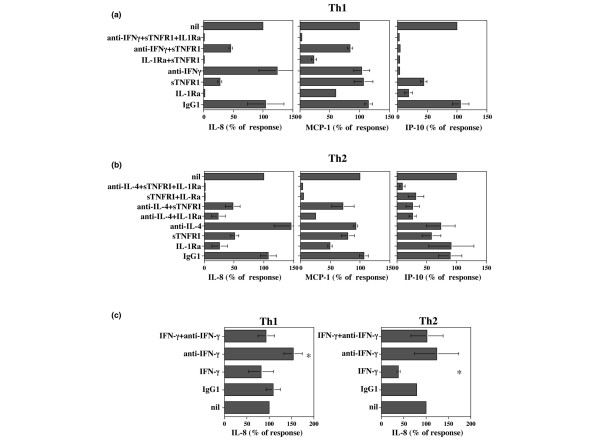
Differential effect of T cell membrane-associated cytokines in inducing IL-8, MCP-1, and IP-10. Fibroblasts were plated at 2 × 104 cells/well; 72 hours later the culture medium was replaced and T cell membranes corresponding to 2 × 105 cells generated from activated Th1 (panel a, n = 2; panel c, n = 4) and Th2 (panels b and c, n = 2) clones were added to the wells in triplicate cultures. Anti-TNF (soluble TNF receptor I; 10-8 mol/l), IL-1 receptor antagonist (2 μg/ml), anti-IFN-γ (10 μg/ml), anti-IL-4 (10 μg/ml), irrelevant monoclonal IgG1 (10 μg/ml) and IFN-γ (1,000 U/ml), alone or in combination, were added to the wells 30 minutes before T cell membranes. Chemokine levels were determined in the supernatants by enzyme-linked immunosorbent assay upon 48 hours of further culture. The bars represent the mean percentage ± standard error of chemokine production in the presence of T cell membranes without blocking agent. (a) IL-8 was 8.8 ± 1.9 ng/ml, MCP-1 was 4.7 ± 0.2 ng/ml and IP-10 was 7.3 ± 1.1 ng/ml. (b) IL-8 was 36.5 ± 8.8 ng/ml, MCP-1 was 6.6 ± 0.9 ng/ml and IP-10 was 0.8 ± 0.3 ng/ml. Note that basal IL-8 levels were fourfold lower and IP-10 tenfold higher in the presence of Th1 compared to Th2 cells. (c) With Th1 cells IL-8 was 6.9 ± 0.7 ng/ml; with Th2 cells IL-8 was 12.0 ± 2.2 ng/ml. *P < 0.05. IFN, interferon; IL, interleukin; IP, interferon-γ inducible protein; MCP, monocyte chemoattractant protein; Th, T-helper.